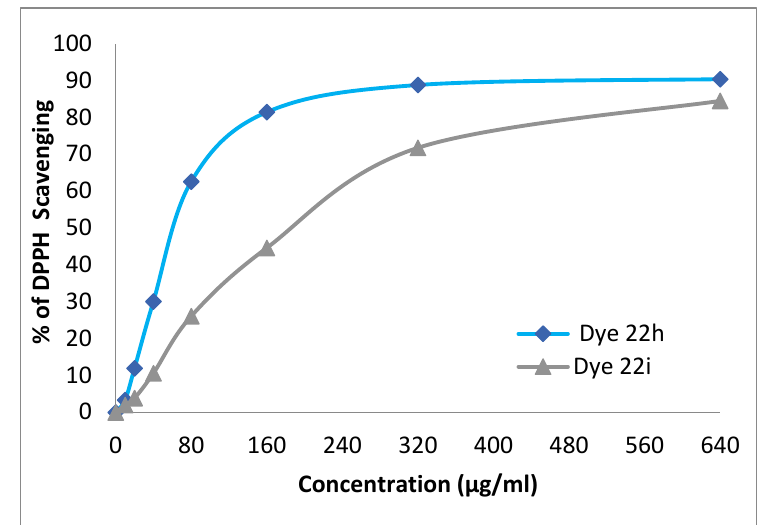
Figure 10. Antioxidant activities of disperse dyes 22h and 22i.